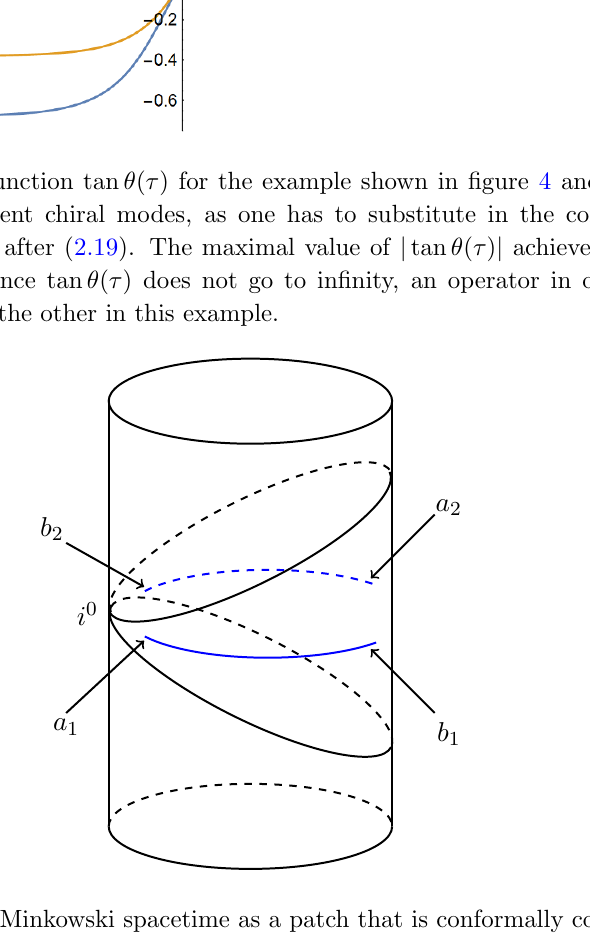
Figure 7 . If we view the Minkowski spacetime as a patch that is conformally compacti(cid:12)ed on the surface of a cylinder, then as a 1 and b 2 are being pushed toward the spatial in(cid:12)nity i 0 , they are in fact getting closer to each